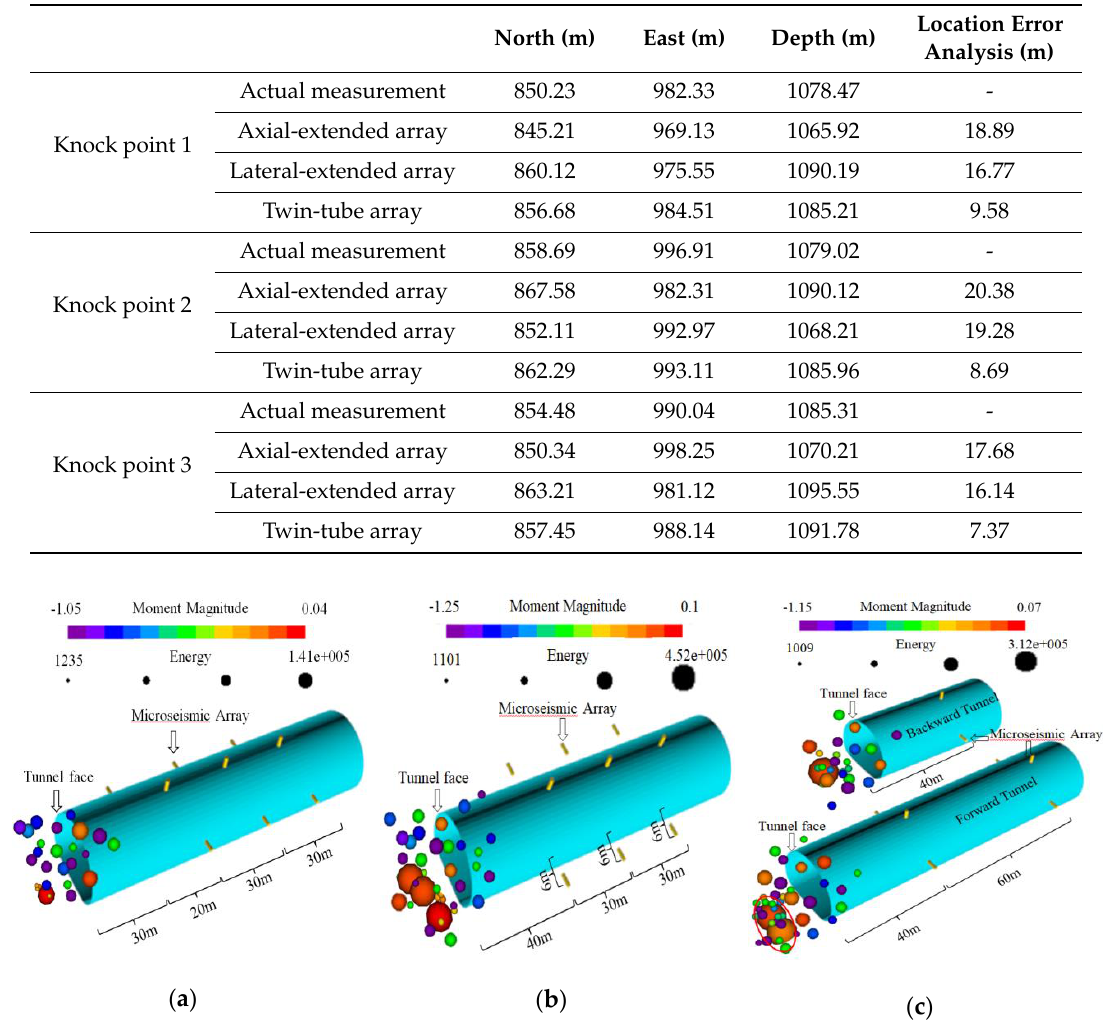
Figure 9. Experimental results obtained from non-enclosed arrays. The size and color of the sphere represent energy (J) and moment magnitude, respectively. ( a ) Axial-extended array; the sensors located on the left and right walls of each row were 20 m apart from each other in the axial direction; ( b ) lateral-extended array; the buried depths of the sensors were only extended to 6 m, and the distance between each monitoring section was 30 m; ( c ) twin-tube array; 9 sensors were arranged in the forward and backward tunnels to monitor the two tunnels well.